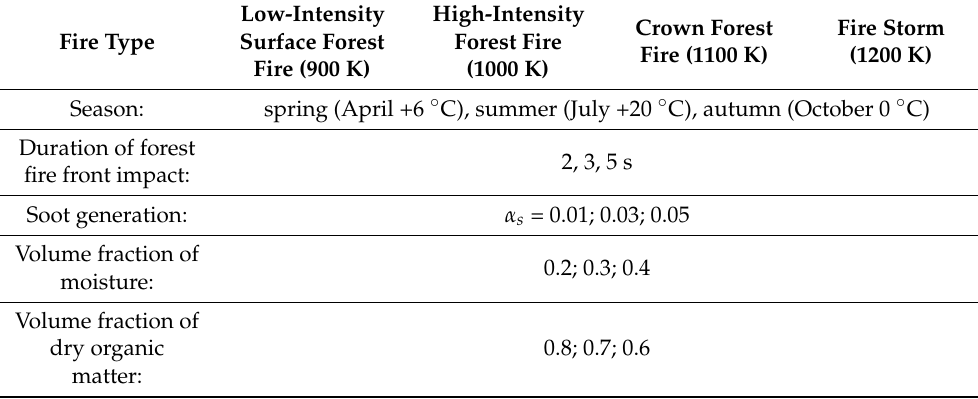
Table 2. Main input parameters for different